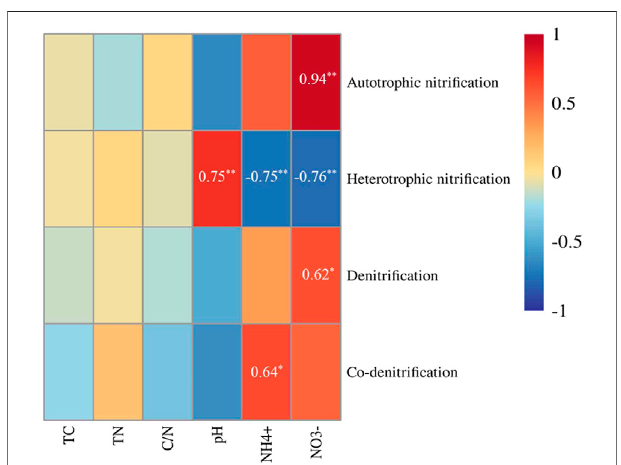
FIGURE 5 | Relationships between soil properties and the N 2 O production rates of N 2 O microbial pathways. Linear regression is used to test the correlation. The correlation coef fi cients are shown when the correlation is statisticallysigni fi cant.**Correlationissigni fi cantatthe0.01;*Correlation is signi fi cant at the 0.05. TC represents the total carbon; TN represents the total nitrogen; C/N represents the ration of carbon to nitrogen.